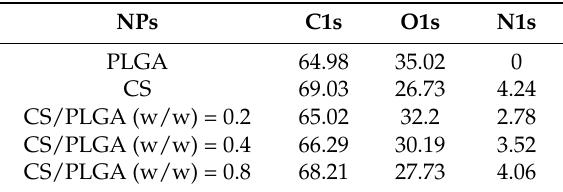
Table 2. Surface atomic concentration of NPs.